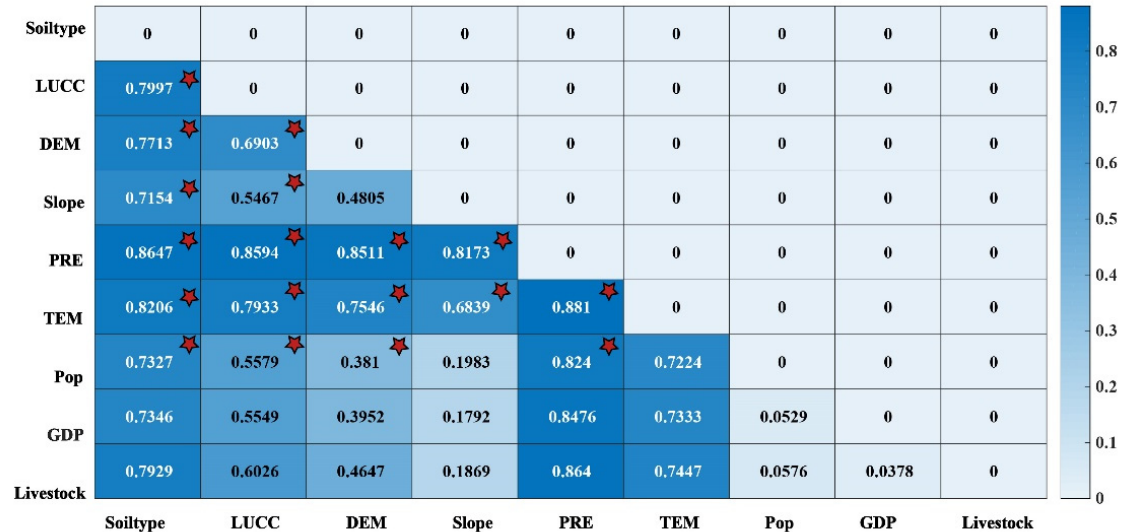
Figure 11. Interaction detector results between factors and mean NDVI in Inner Mongolia from 2000 to 2019. Note: positions marked with red stars in the figure represent a bi-variable enhancement of the interaction between two different interaction factors, and non-marked positions represent a non-linear enhancement of the interaction between two different interaction factors).